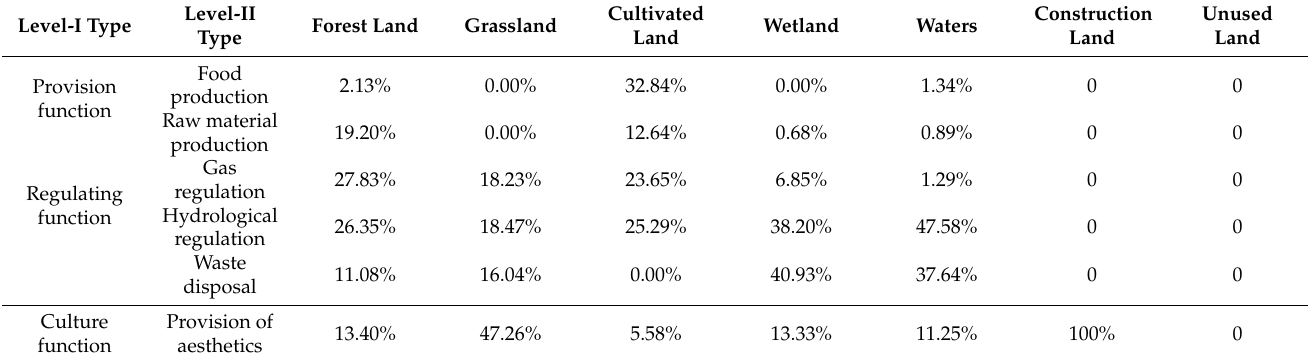
Table 1. Percentages of ecosystem service functions generated by different land use types.